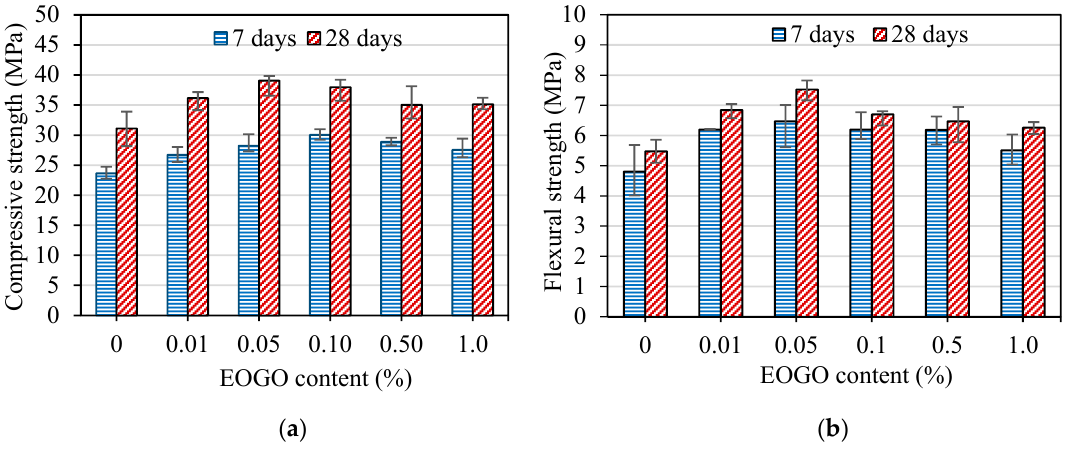
Figure 6. ( a ) Compressive strength and ( b ) flexural strength of EOGO-cement pastes with the wet-mix design method.